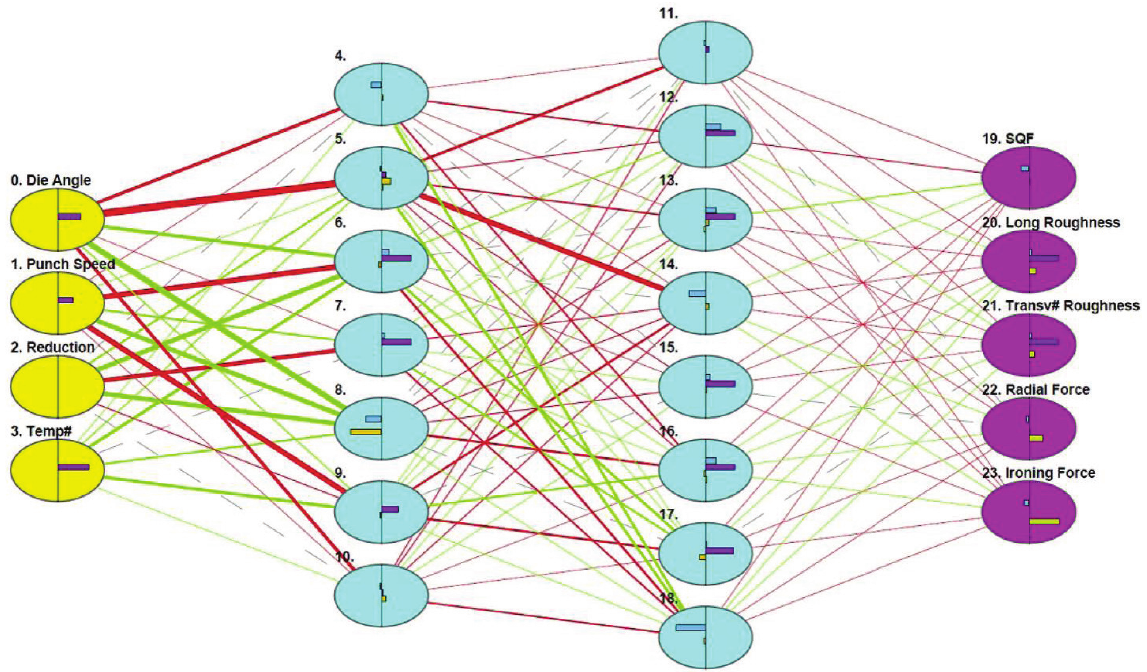
Figure 9. The ANN created for the ironing process. The four input variables are on the left, and the five output variables on the right. Blue columns are the two hidden layers. Different line thicknesses represent the connection